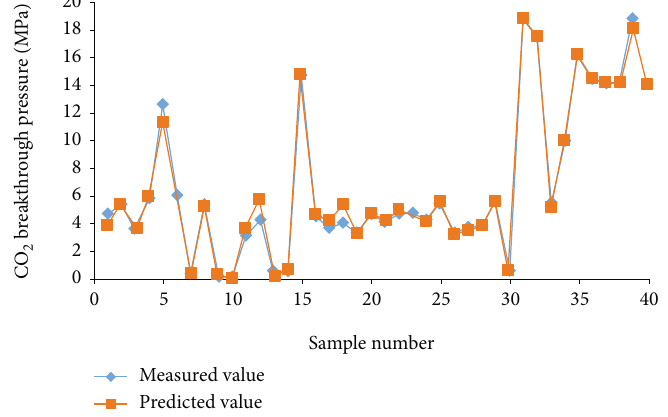
Figure 13: Relationship between measured and predicted values.